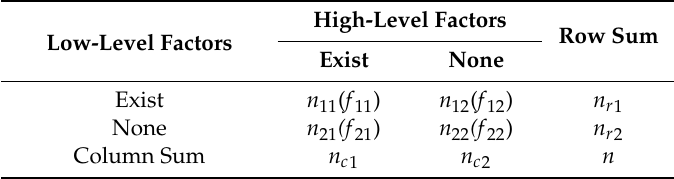
Table 2. Calculation of the chi-square ( χ 2 ) value: 2 × 2 contingency